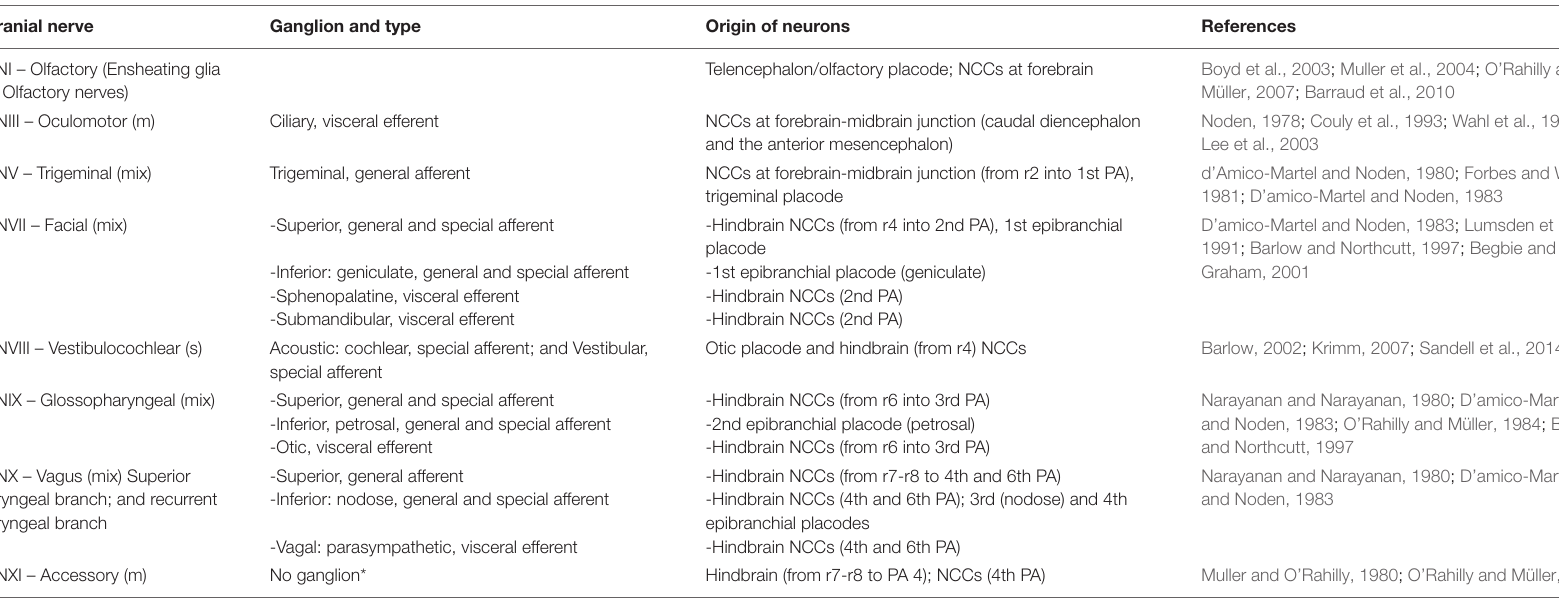
TABLE 1 | Contributions of neural crest cells and placodes to ganglia and cranial